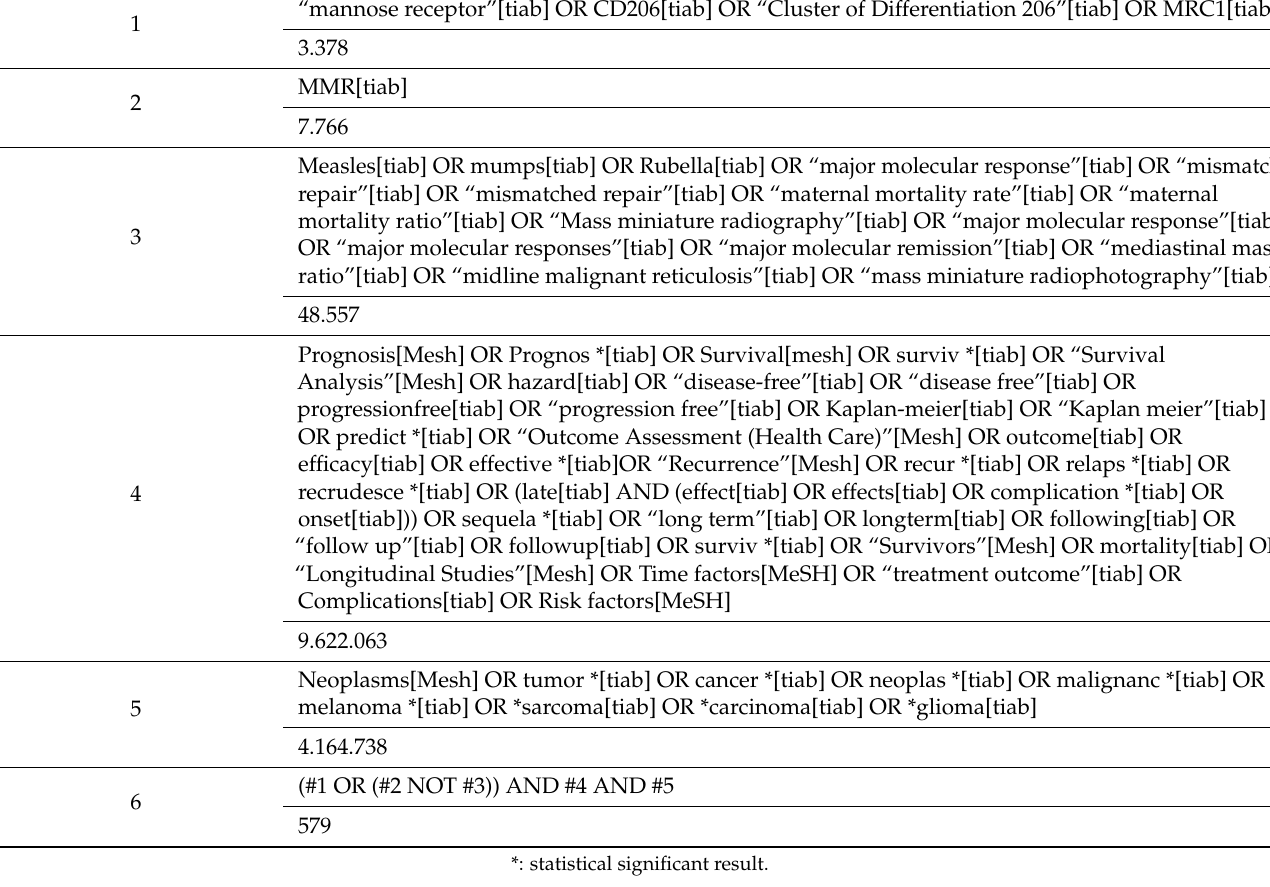
Table A1. PubMed search string.